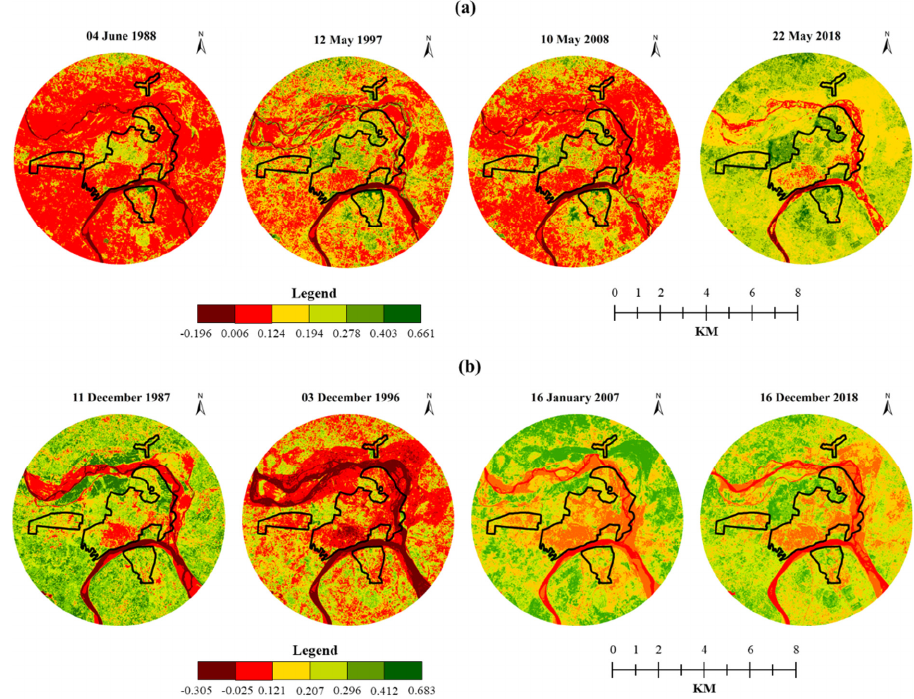
Figure 10. Seasonal NDVI dynamics in Prayagraj city (1987–2018): ( a ) summer and ( b ) winter.